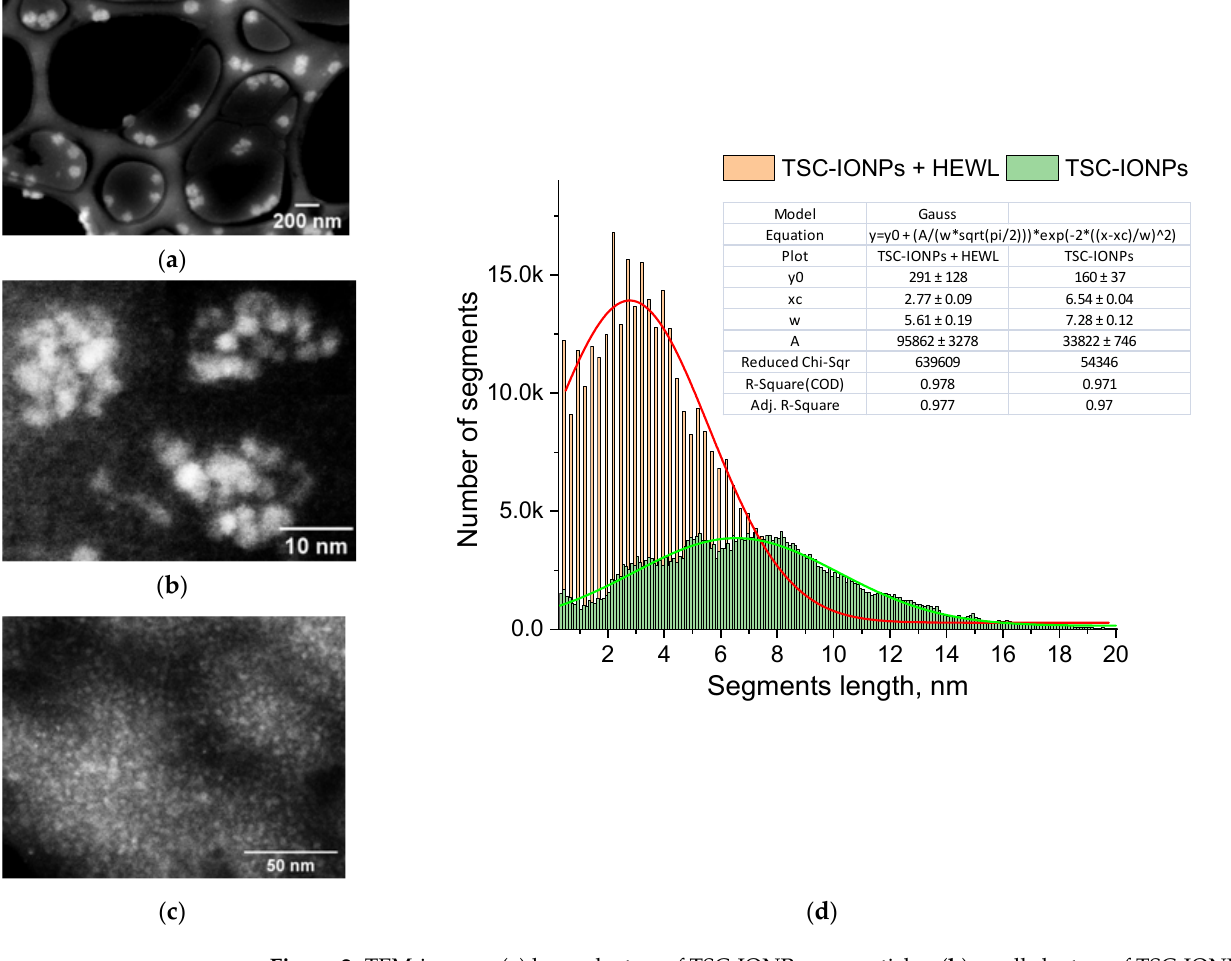
Figure 2. TEM-images: ( a ) large clusters of TSC-IONP nanoparticles, ( b ) small clusters of TSC-IONPs, ( c ) TSC-IONPs (10 13 mL − 1 ) with HEWL (5 mg/mL), ( d ) the distribution of the lengths of the segments connecting the boundary pixels of the NPs in the TEM images ( b , c ). The lines show the Gaussian approximation of the distributions of segments for NPs in the clusters (green line, ( b )) and NPs in the aggregates with HEWL (red line, ( c )).